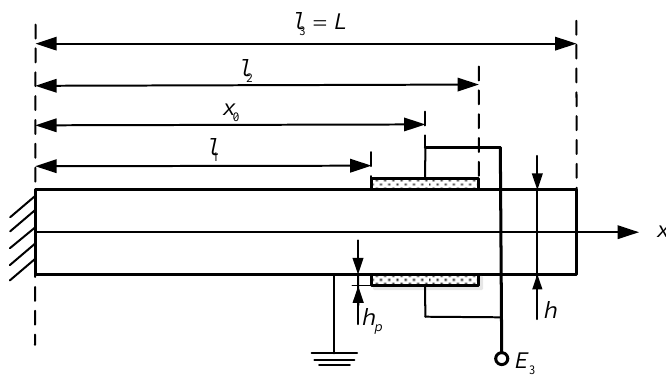
Figure 4. Dynamics model of the cantilever touch beam.